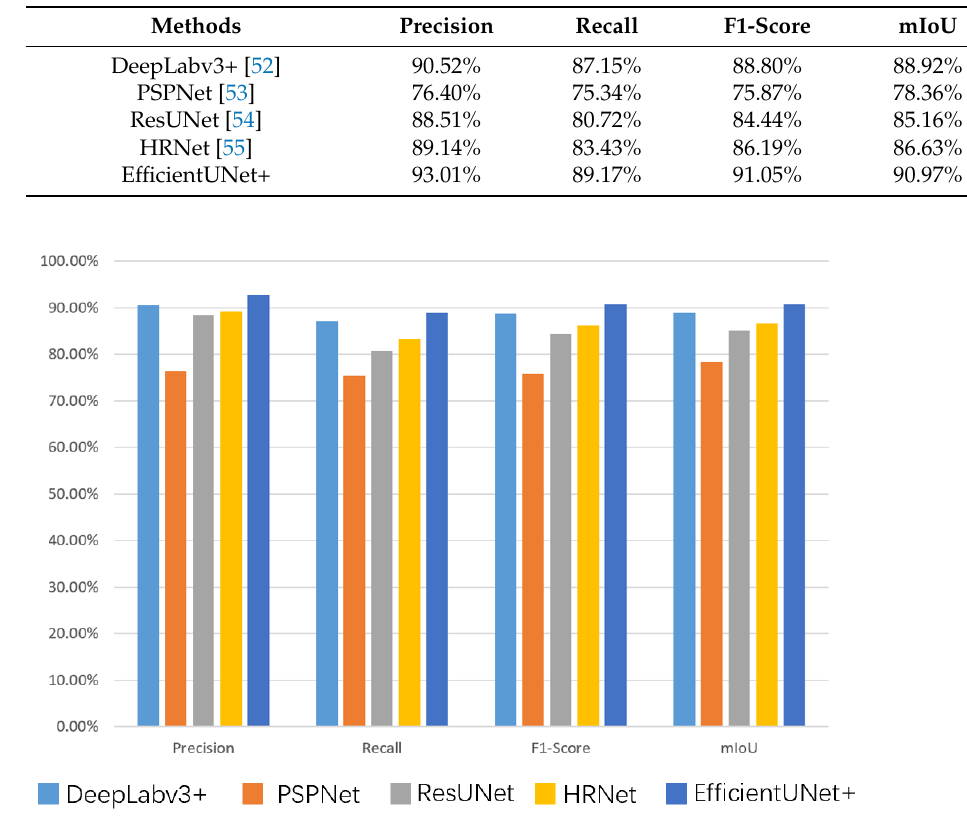
Figure 11. Accuracy comparison chart of different